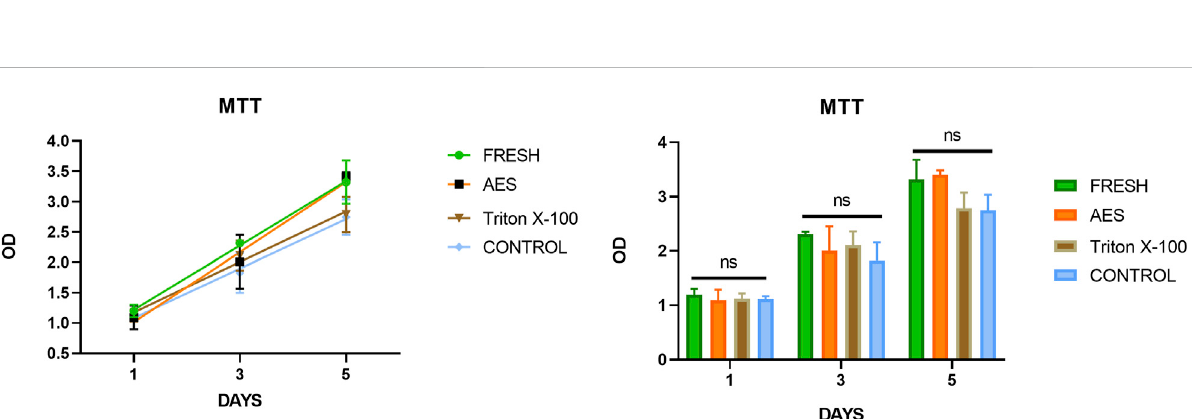
Frontiers in Bioengineering and